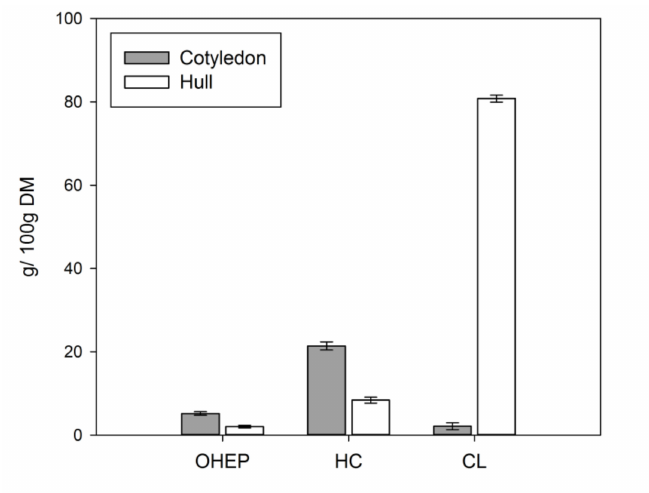
Figure 3. Yields of pectin-like fraction (OHEP), hemicellulose fraction (HC), and cellulose-lignin fraction (CL) isolated from the cotyledon and hull cell wall material of L. angustifolius L. Boregine ( n = 3).